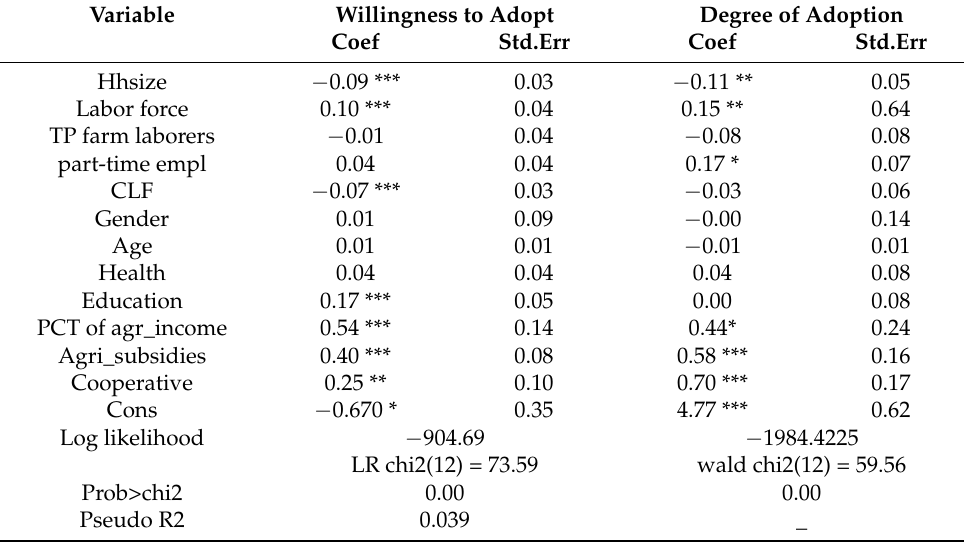
Table 3. Estimation results of the double-hurdle model.